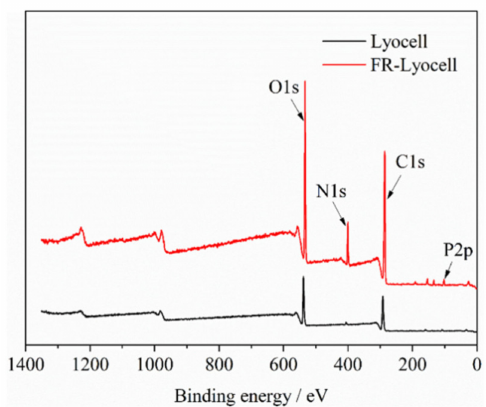
Figure 4. XPS spectra of lyocell and FR − lyocell